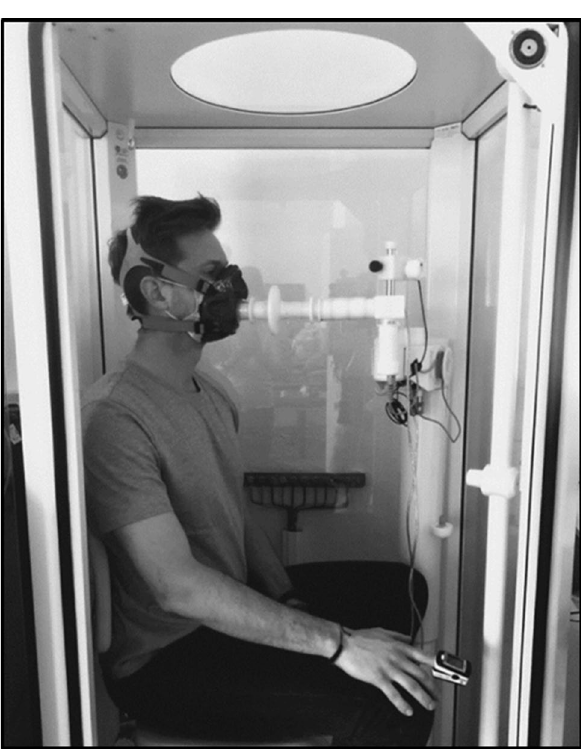
Figure 1. Timeline of the study; Pre-examination: informed consent, medical history, body plethysmography, DIET double incremental cycle ergometer test to detect the lactate minimum, Constant-load-test with and without mask: in randomized order, impedance cardiography, blood pressure, ergo-spirometry and blood lactate concentration.